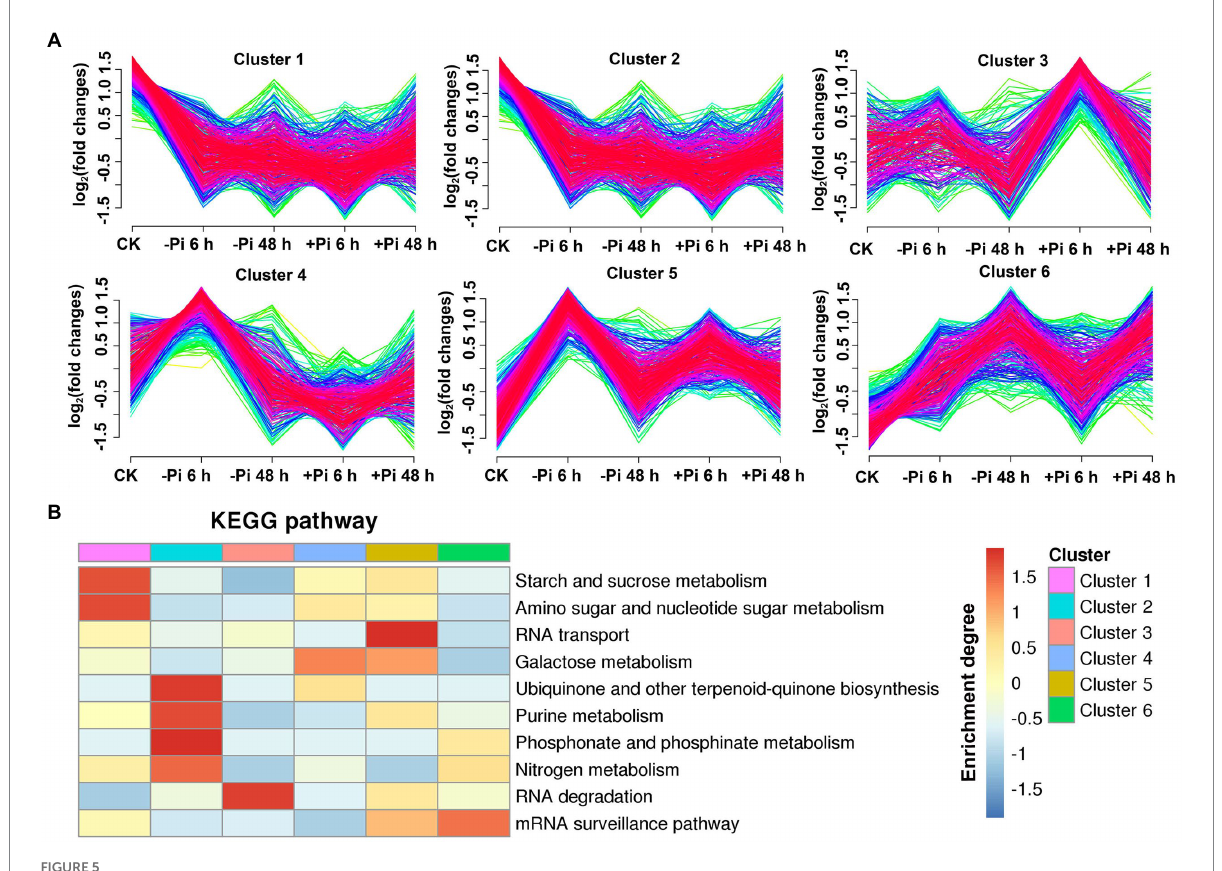
FIGURE 5 Clustering analysis of phosphorylated proteins based on their expression pattern in response to Pi starvation and recovery using a Mfuzz package (A) ; and KEGG pathways that are overrepresented in each cluster based on the relative phosphorylation intensity relative to control (B) . –Pi, Pi starvation; +Pi, Pi recovery. The colored scale bar shows the enrichment degree of pathways in order perform z-score processing on-log (Fisher’s exact test p value). KEGG, Kyoto Encyclopedia of Genes and Genomes; Pi, intracellular